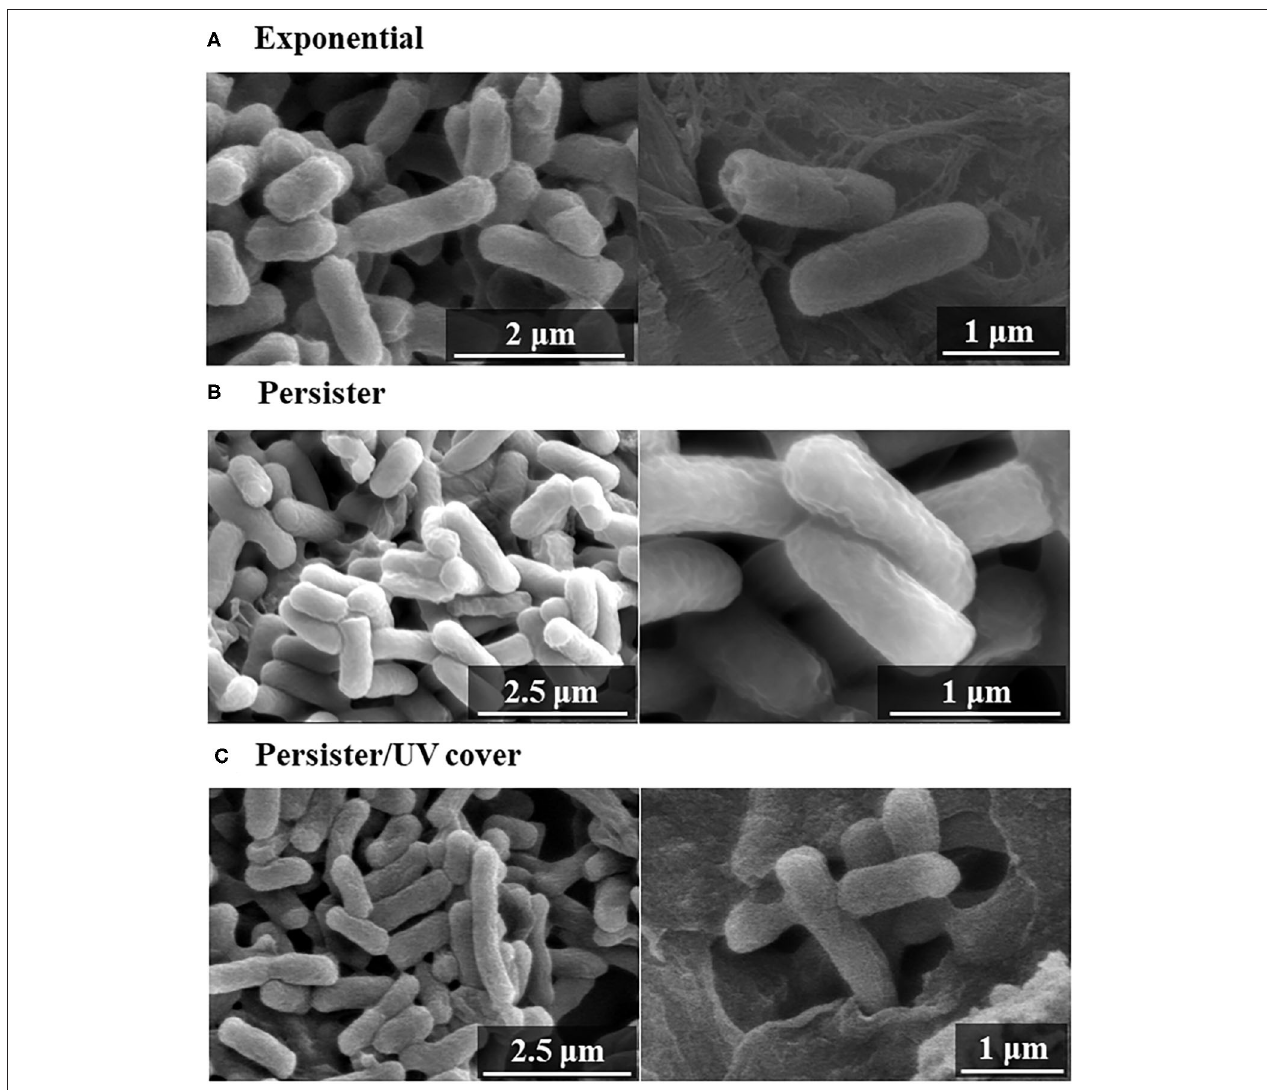
FIGURE 4 | Scanning electron microscopy (SEM) images after UV irradiation. Bacterial cell wall observation of (A) exponential cells, (B) persister cells, and (C) persister cells treated with UV with cover for 10min (UV cover) by SEM.